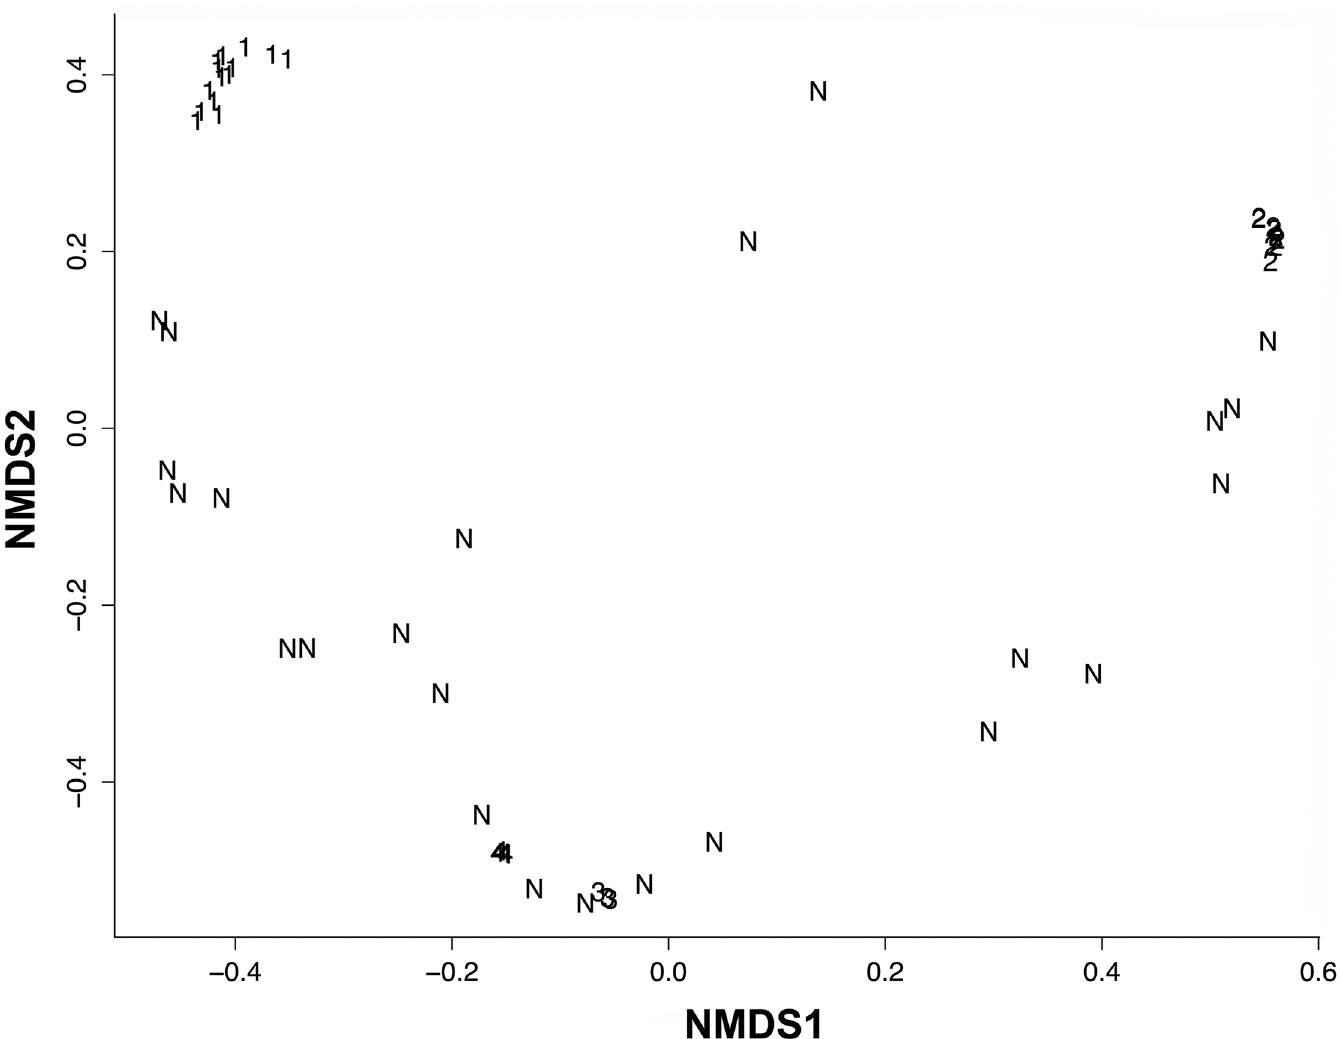
Fig 4. Species clusters in the first two dimensions of nonmetric multidimensional scaling analysis. Data obtained according to the ranges of 63 anuran species from Brazilian Restingas mapped on a 1° x 1° cell grid, analyzed in MCLUST. Characters indicate model-based clustering with noise